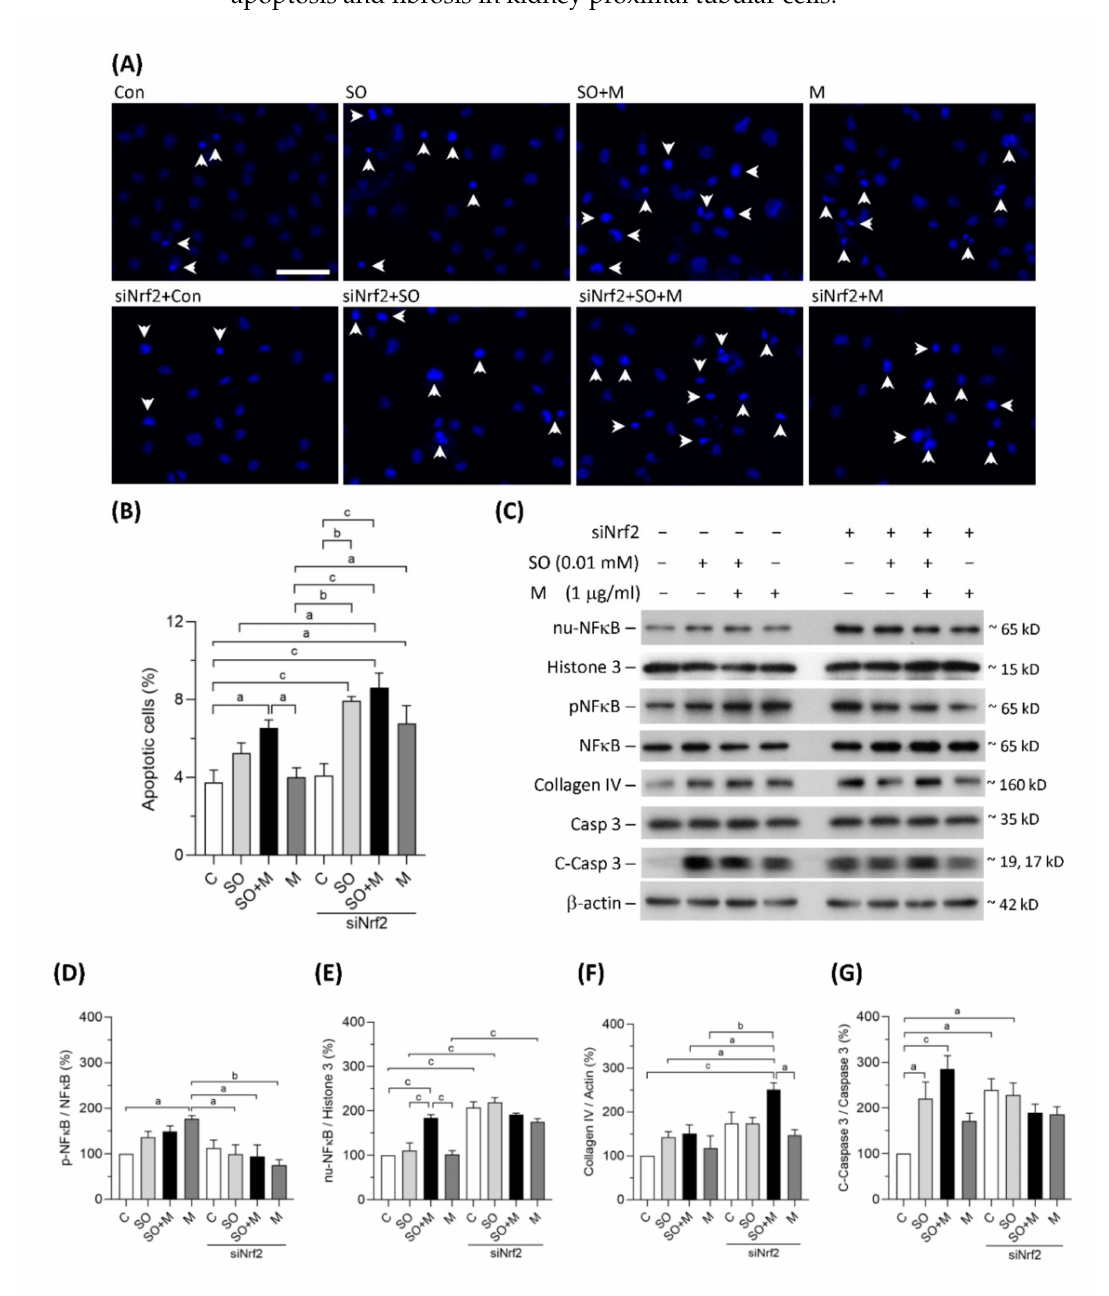
Figure 3. Apoptosis and the expression of proteins related to inflammation, fibrosis, and apoptosis in HK-2 cells. ( A ) Apoptotic HK-2 cells were detected by a Hoechst 33342 fluorescent probe. The apoptotic cells were indicated by white arrowheads. Scale bar = 75 µ M. ( B ) Quantified results of the apoptotic cells. ( C ) The representative immunoblot images for nuclear proteins of NF- κ B (nu-NF κ B) and histone 3, phosphorylated protein of NF- κ B (pNF κ B), and total proteins of NF- κ B, collagen IV, cleaved-caspase 3 (c-Caspase 3), caspase 3, and β -actin. The protein expressions were detected by western blotting. ( D – G ) The quantified results of the blots. The cells were stimulated with 1 µ g/mL melamine (M) and/or 0.01 mM sodium oxalate (SO) for 24 h. Con and C: control cells without treatment; siNrf2: the cells treated with Nrf2 small interference RNA for 24 h. Data are mean ± SE ( n = 3). a: p < 0.05; b: p < 0.01; c: p <